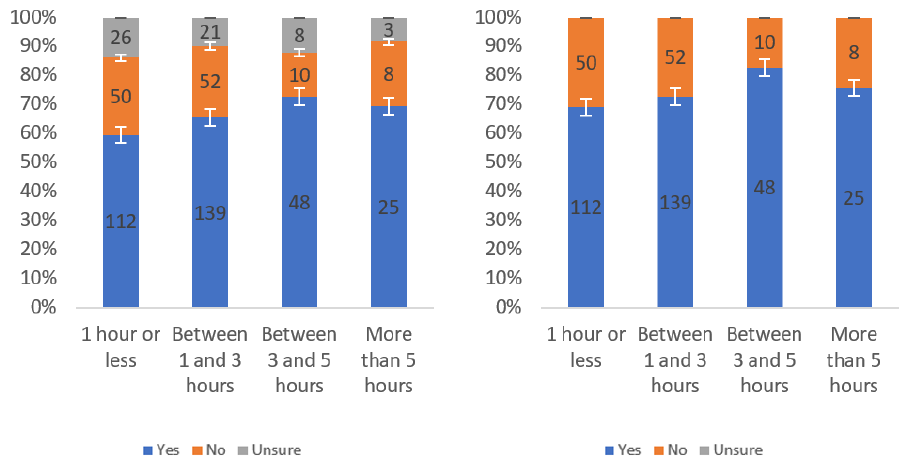
Figure A33. Responses regarding label helpfulness by internet usage level including ( left ) and ex- cluding ( right ) unsure responses.